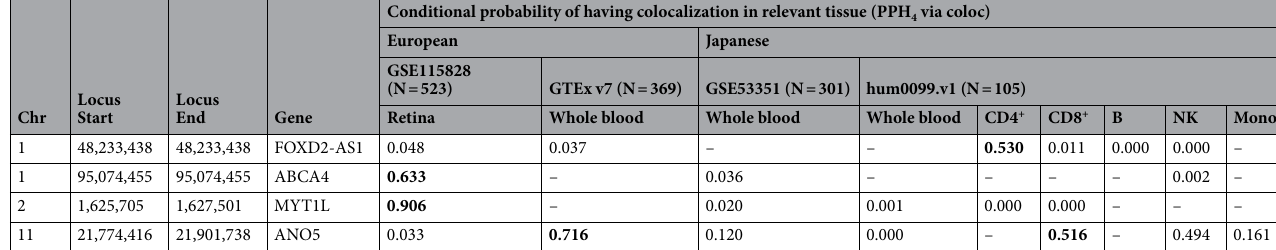
Table 4. List of loci with a high colocalization identified via GWAS and eQTL colocalization analysis. A hyphen stands for no feature in the eQTL data. The figures in bold are above 0.5 of PPH 4 . CD4 + CD4 + T cells,